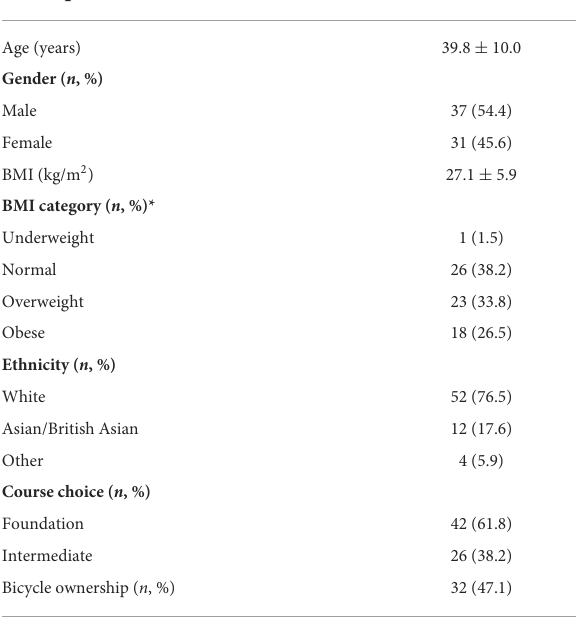
TABLE 5 Participant baseline characteristics ( n =